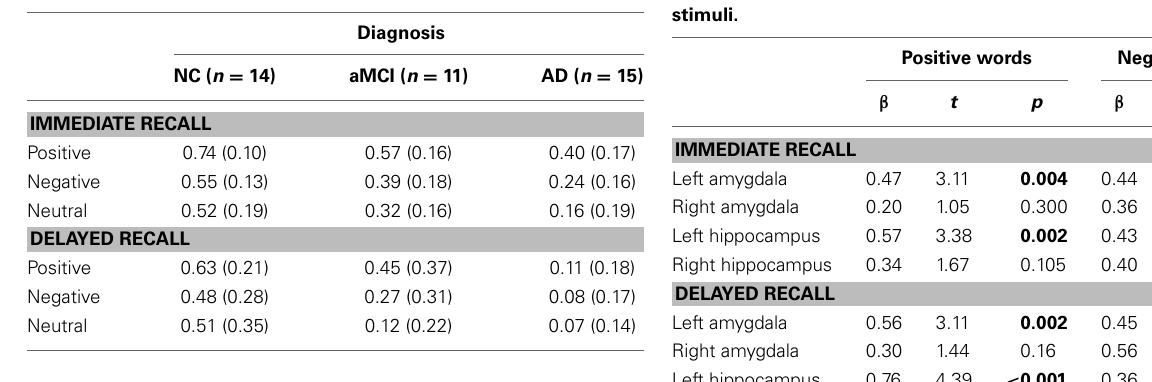
Table 3 | Mean proportions correct at immediate and delayed recall for each valence category [mean (standard deviation)] and for each diagnostic group.